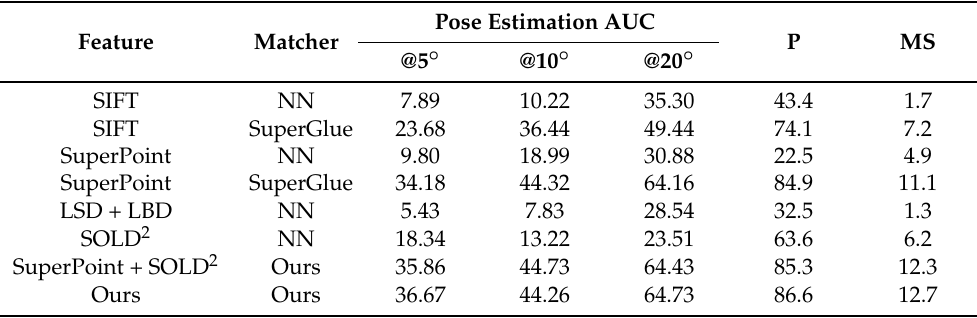
Table 5. Experimental results of the pose estimation. Matching PL-Net features with HAGNN resulted in a significantly higher pose accuracy (AUC), precision (P), and matching score (MS) than with handcrafted or other learned